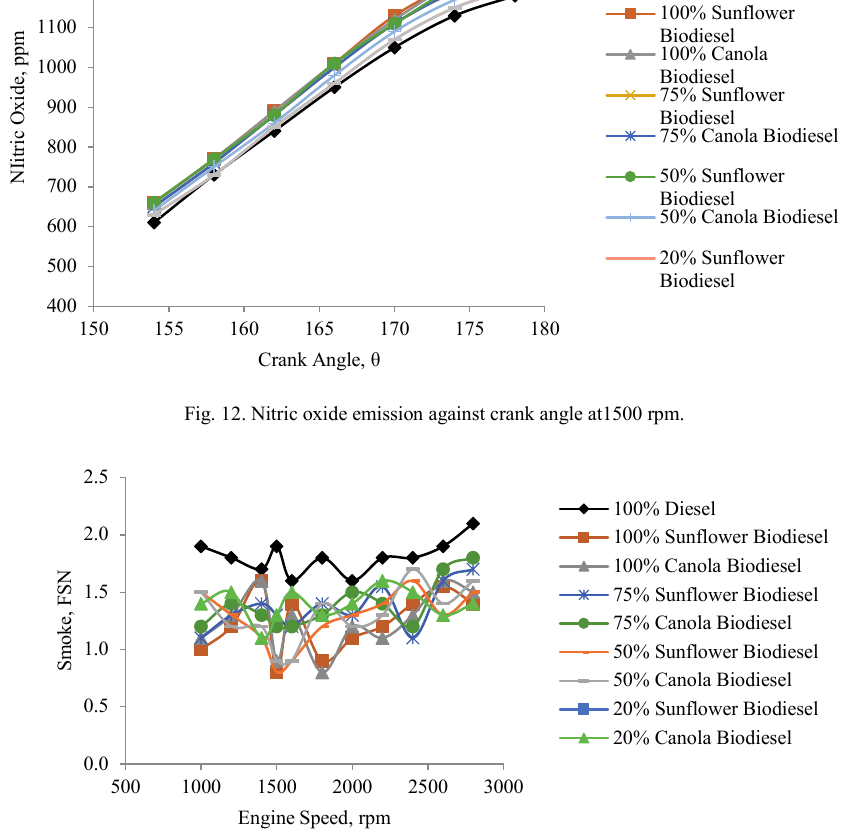
Fig. 13. Smoke emission against engine